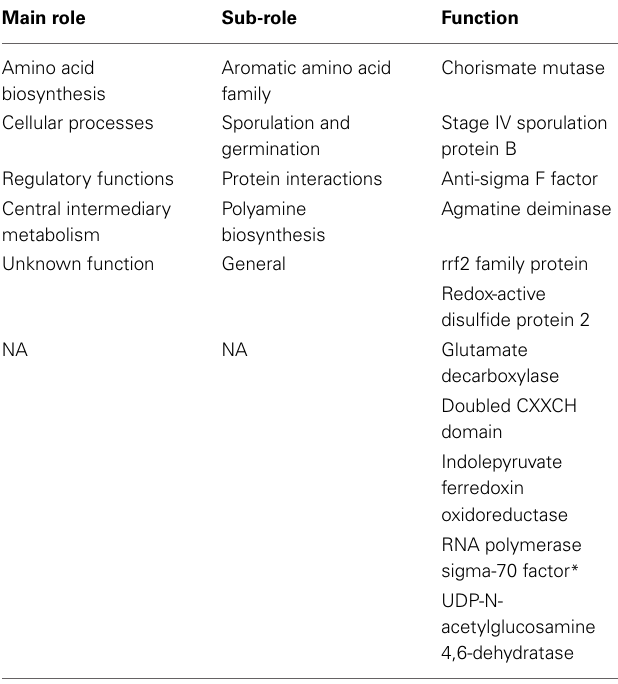
Table 5 | Candidate functions involved in C. difficile colonization